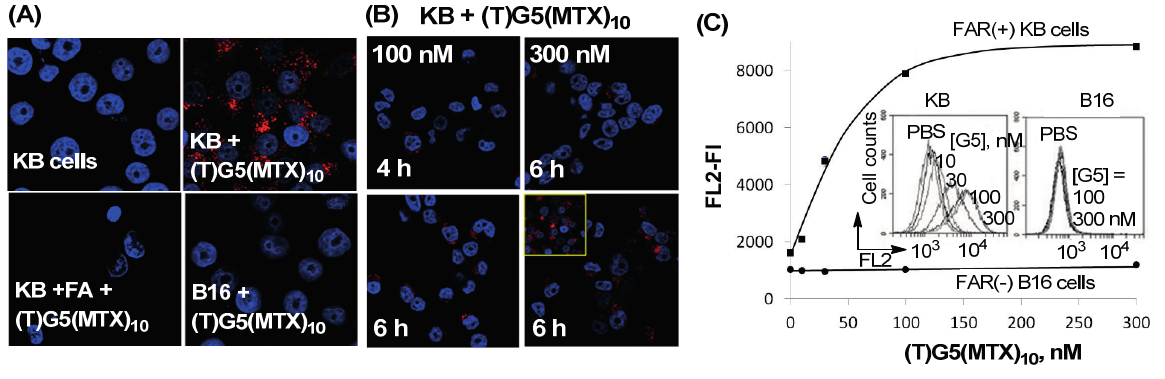
Figure 4. ( A , B ) Confocal microscopy images showing FAR-specific and time-dependent binding and uptake of (TAMRA)G5(MTX) 10 in FAR(+) KB and FAR( − ) B16-F10 cells [51,52]; ( C ) Flow cytometric analysis. Inset: histograms showing the FL2 fluorescence (FL) of 10,000 KB or B16 cells. TAMRA = 5-carboxytetramethylrhodamine. Staining: Nuclei (DAPI; blue); Cytosol (TAMRA;